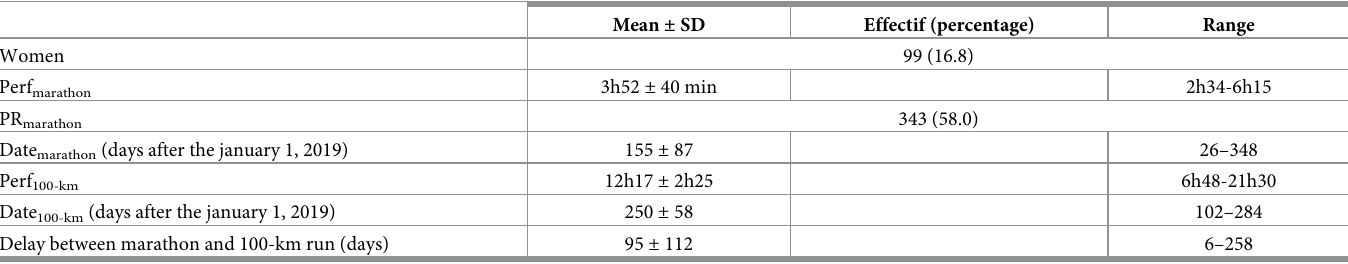
Table 2. Characteristics of 591 athletes and their performances in marathon and